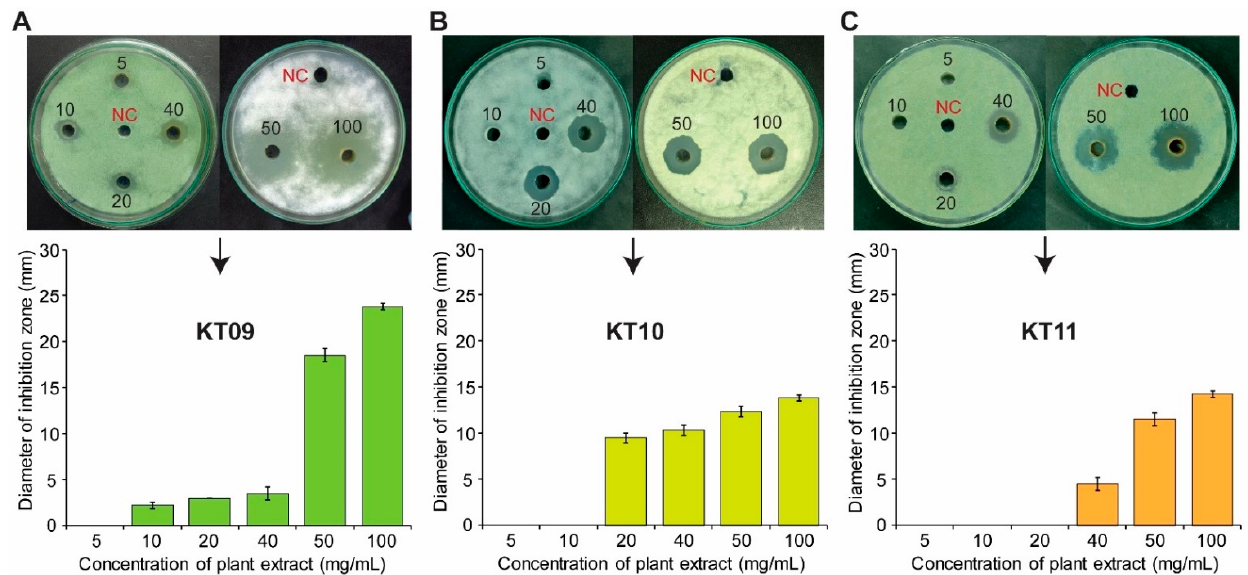
Figure 1. Evaluating the antifungal efficacy of the three selected crude extracts from M. bealei (KT09) ( A ), F. semicordata (KT10) ( B ), and G. montanum (KT11) ( C ) against P. digitatum using the agar well diffusion method. The plant extracts were prepared at concentrations of 5–100 mg/mL. A 50 µL volume of fungal spore suspension (10 6 spores/mL) was spread onto a PDA plate, and 6-mm-diameter wells were punched and filled with 50 µL of each extract. DMSO (10%) was used as the negative control (NC). The plates were incubated at 25–30 °C for 3–4 days. Experiments were performed in triplicate, and data are presented as means ± standard deviations (SD).